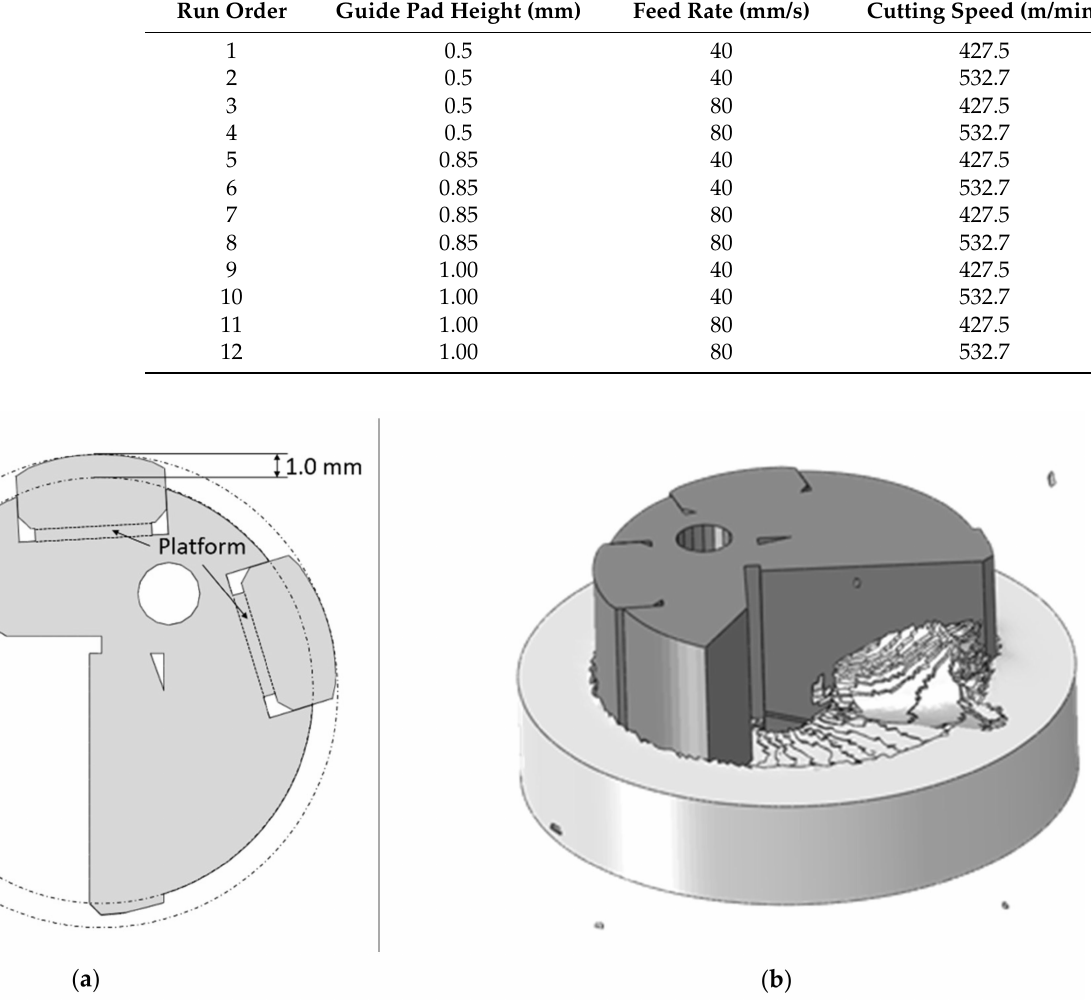
Table 6. Full factorial experiment.